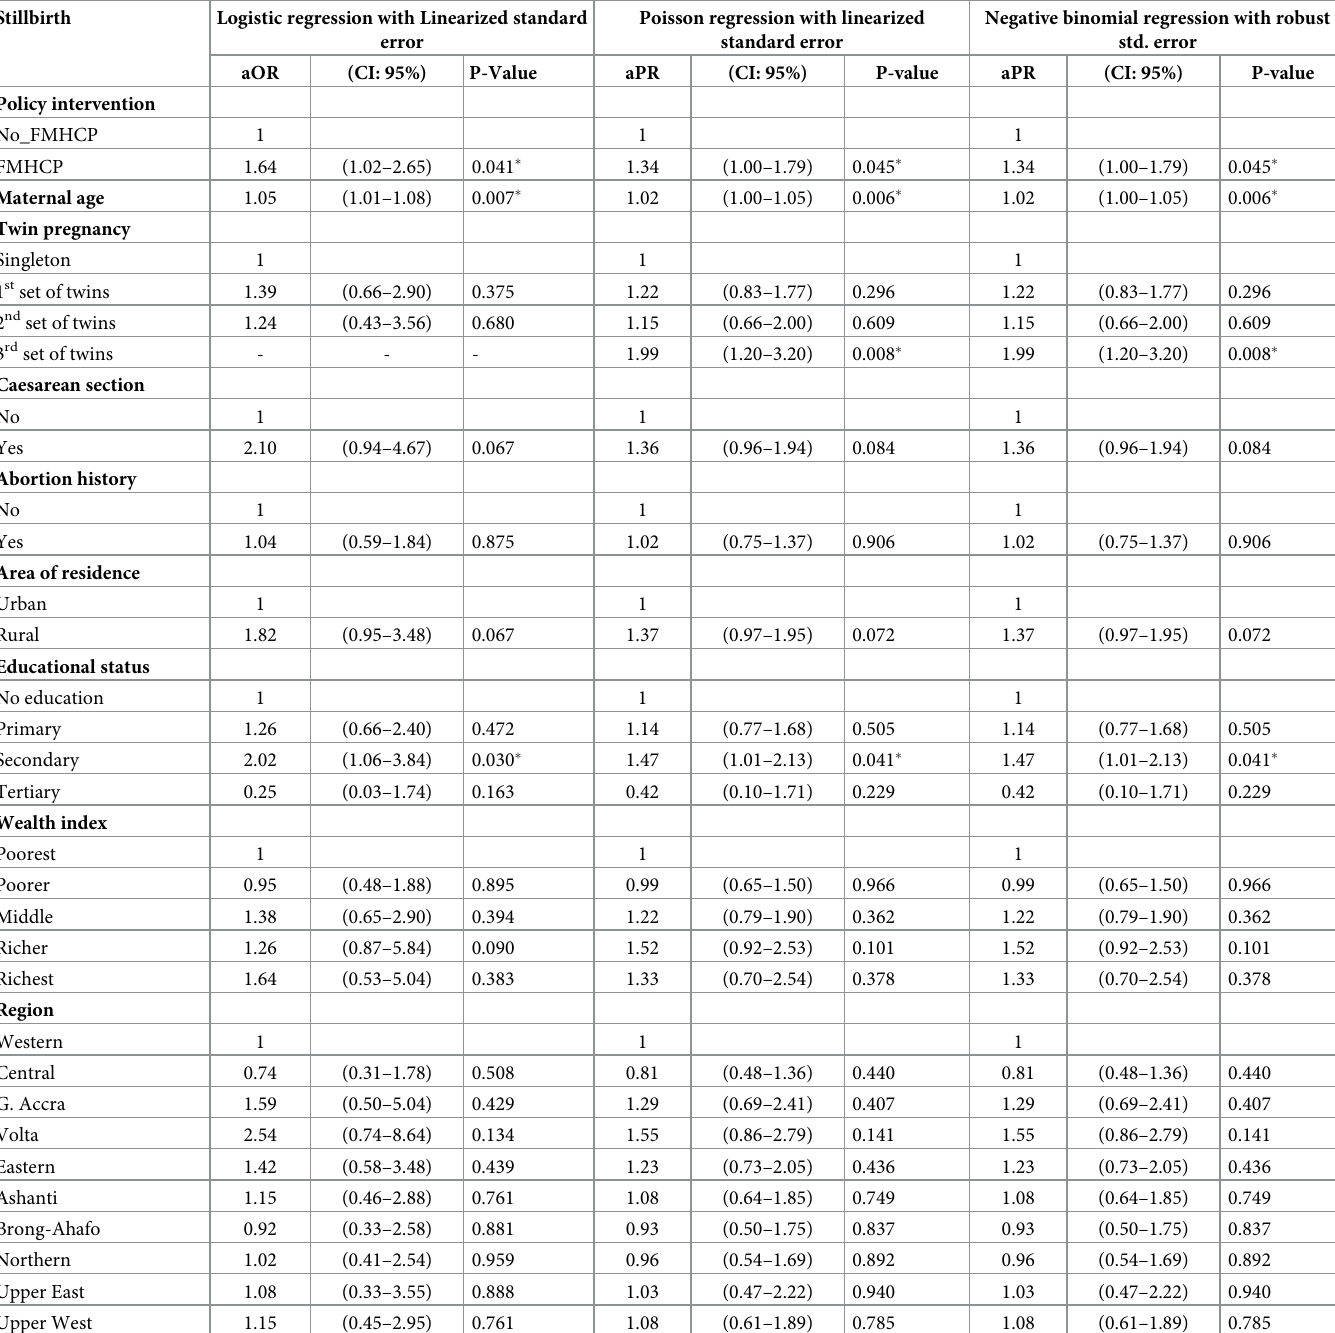
Table 2. Association between the free maternal health care policy and risk of stillbirth. Stillbirth Logistic regression with Linearized standard